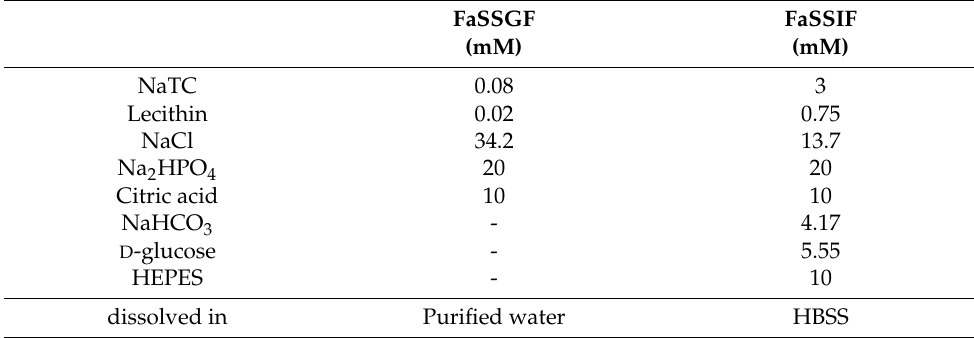
Table 1. Compositions of the donor fluid used for the BE checker.